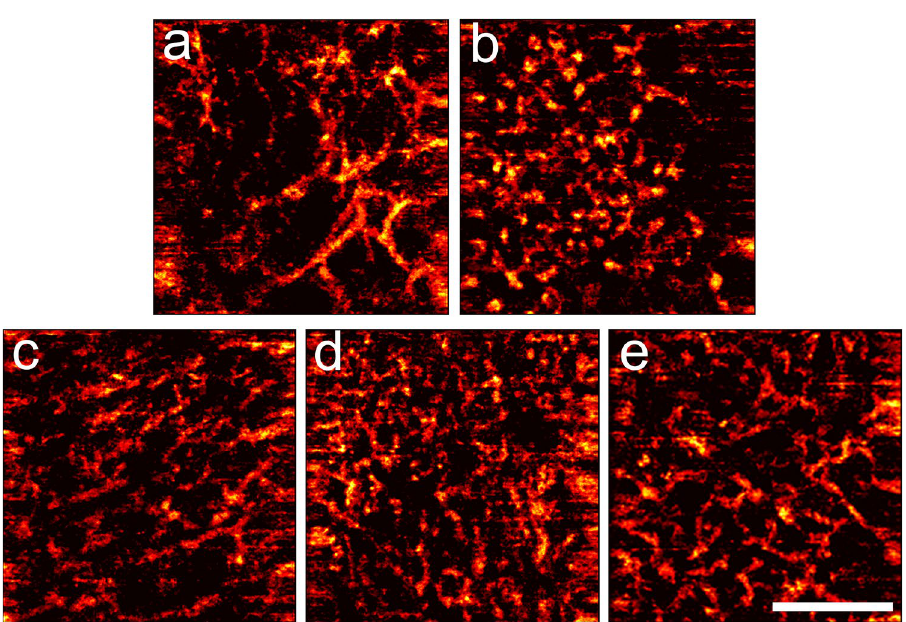
Figure 6. Representative OCA images of benign and malignant lesions from dermoscopic equivocal group. Vessel networks in lentigo simplex ( a ), dysplastic nevi ( b ), melanoma in situ ( c ), lentigo maligna melanoma ( d ), and superficial spreading melanoma ( e ). Scale bar is 1 mm, applicable to all